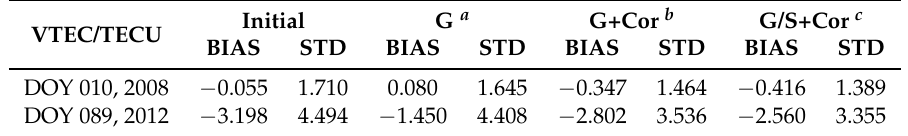
Table 2. Statistics of VTEC’s daily residual between GIMs from the IGS and the ionospheric assimilation results under different strategies Initial G a G+Cor b G/S+Cor c VTEC/TECU BIAS STD BIAS STD BIAS STD